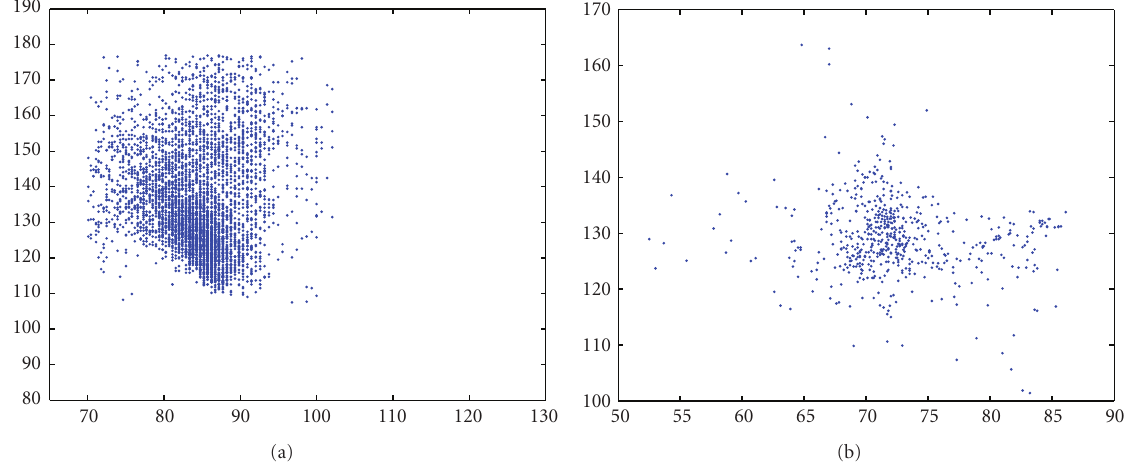
Figure 2: SBP against HR for a healthy (a) and an abnormal (b) case.